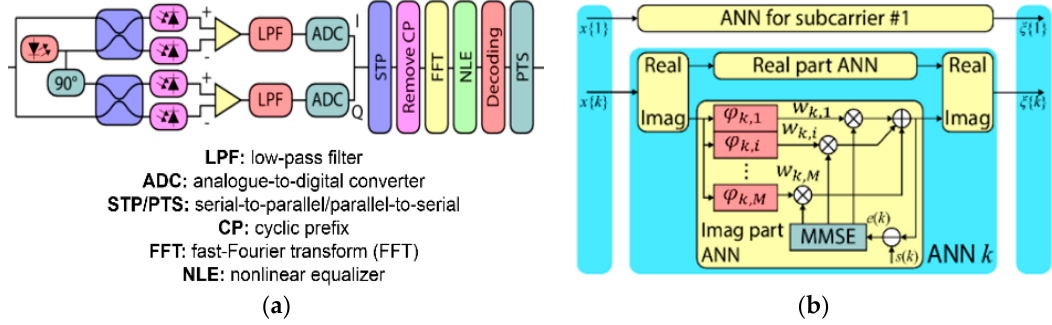
Figure 3. ( a ) CO ‐ OFDM receiver including non ‐ linear equalization (NLE). ( b ) Artificial neural